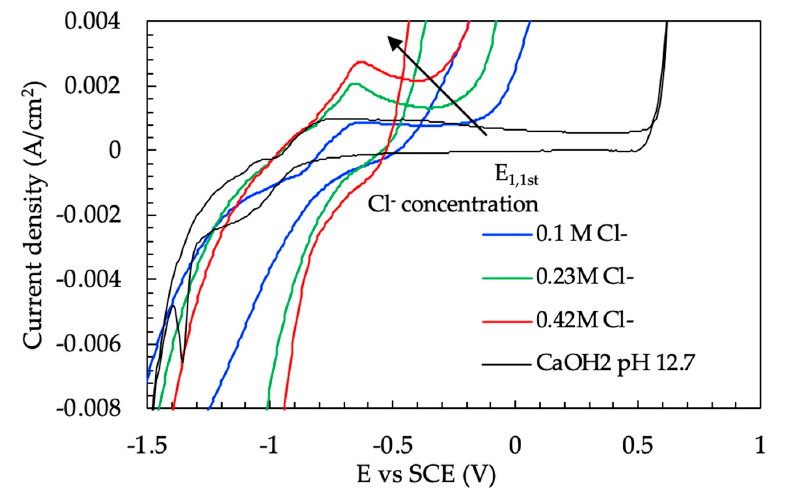
Figure 4. Effect of chloride ions on the first cycle of the voltammetric curves of steel in saturated Ca(OH) 2 solution at pH 12.7.